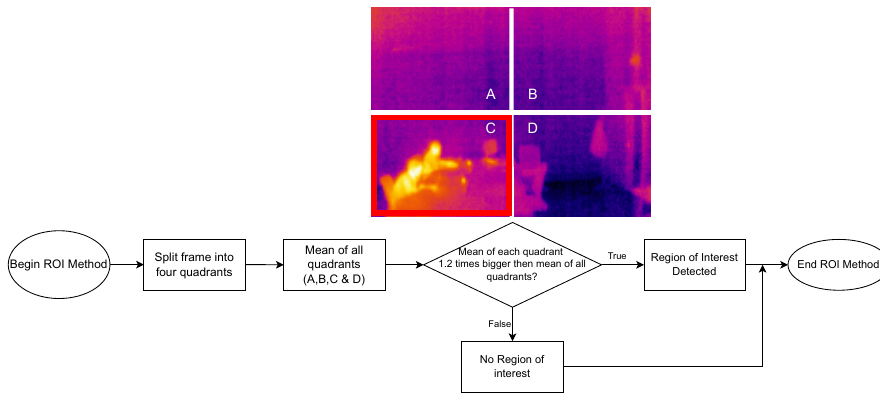
Figure 9. Flowchart for Method B (region of interest method).